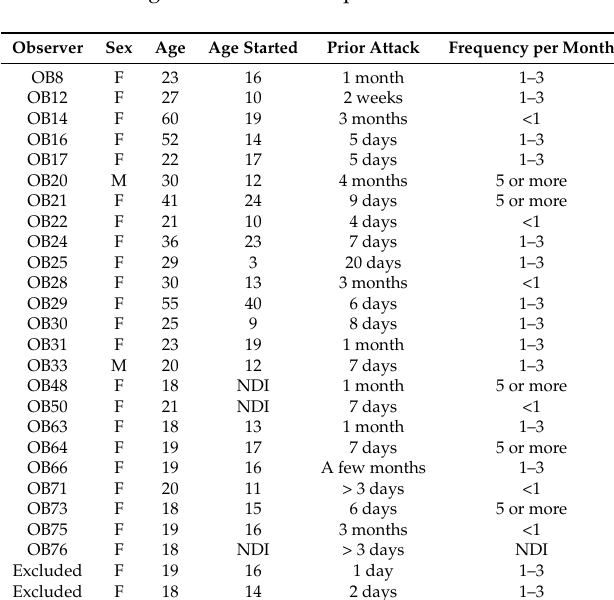
Table 1. Migraine observers’ reports of clinical